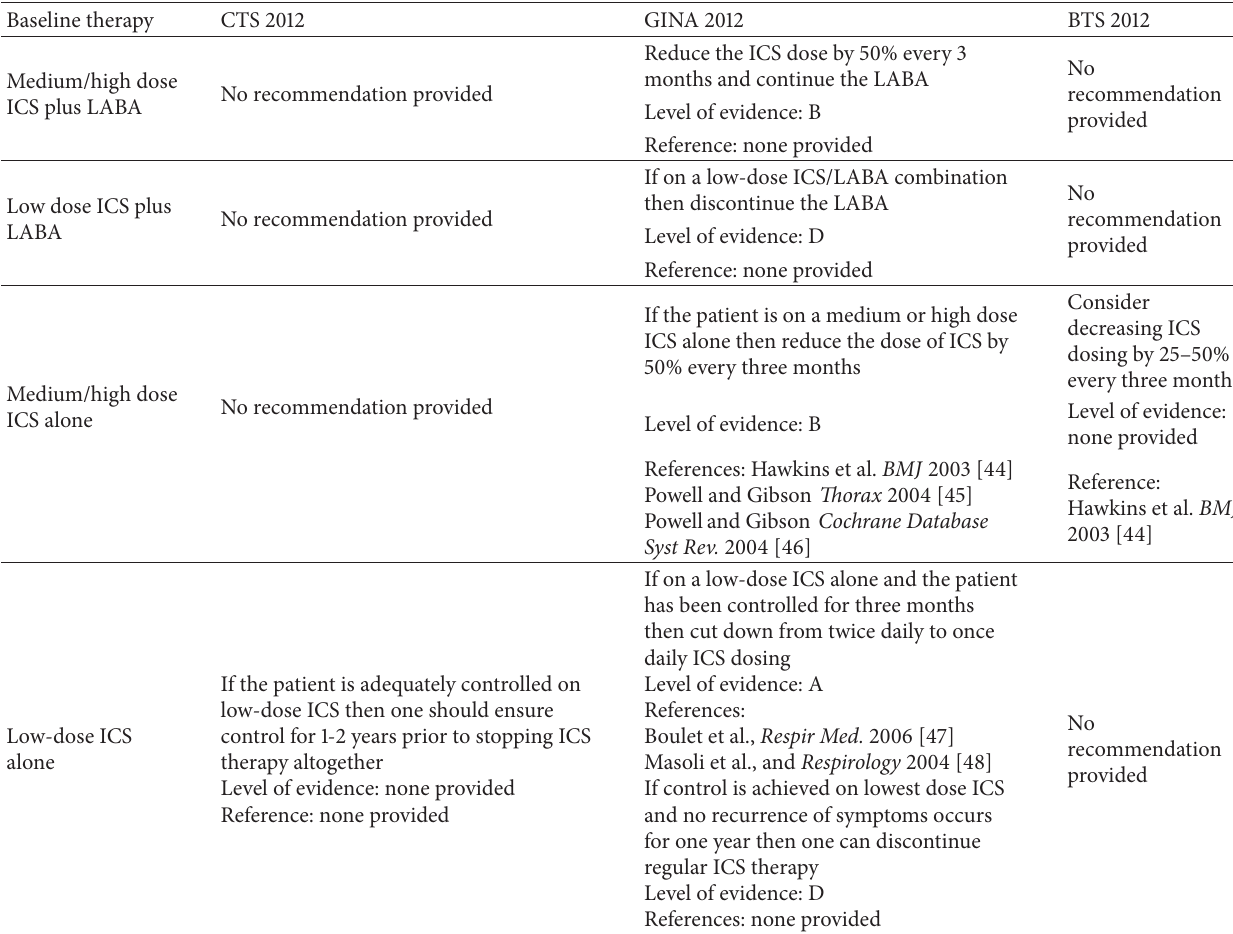
Table 3: Guideline criteria, levels of evidence, and papers cited for controller